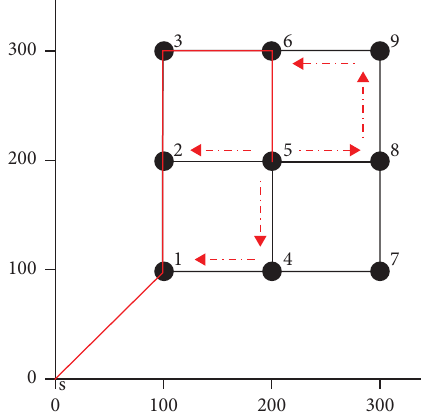
Figure 2: Red line for a TFS operating a grid network and allowed detours and stop